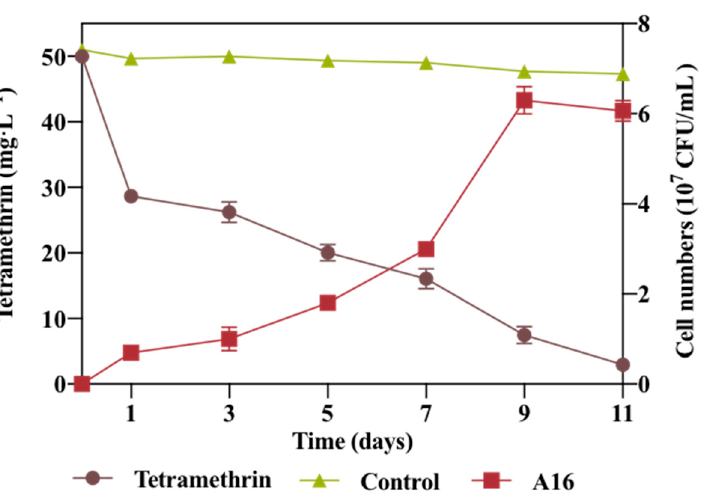
Figure 2. Growth-linked degradation of tetramethrin in mineral salt medium (MSM) by strain A16.